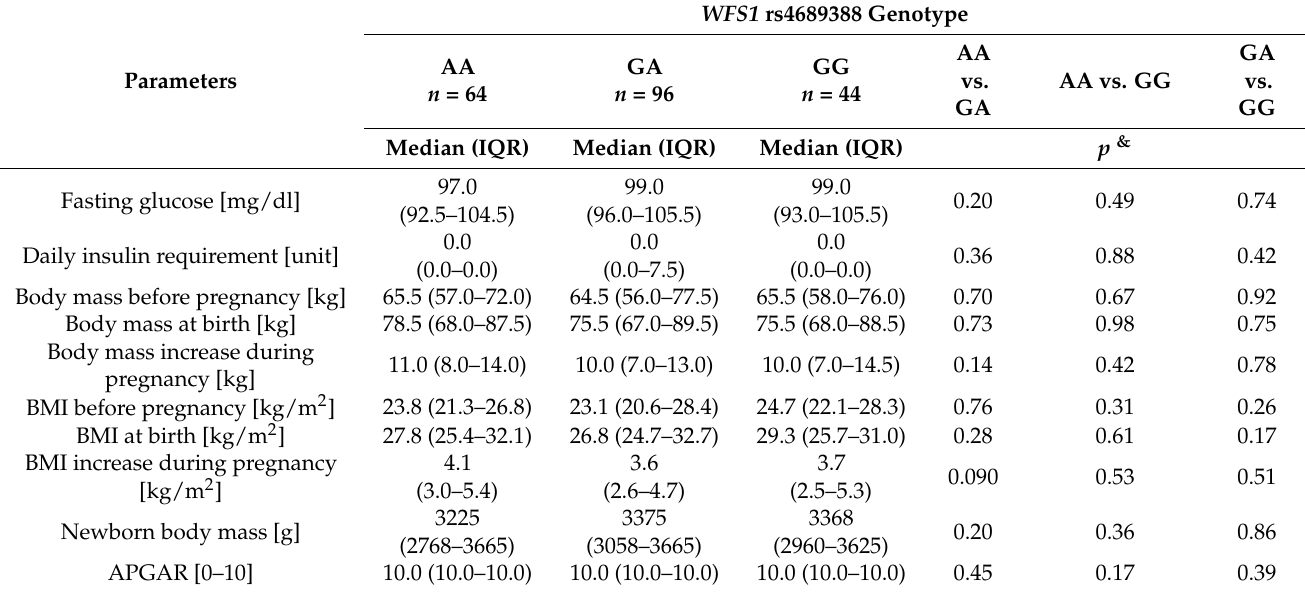
Table 6. Clinical parameters of women with GDM stratified according to WFS1 rs4689388